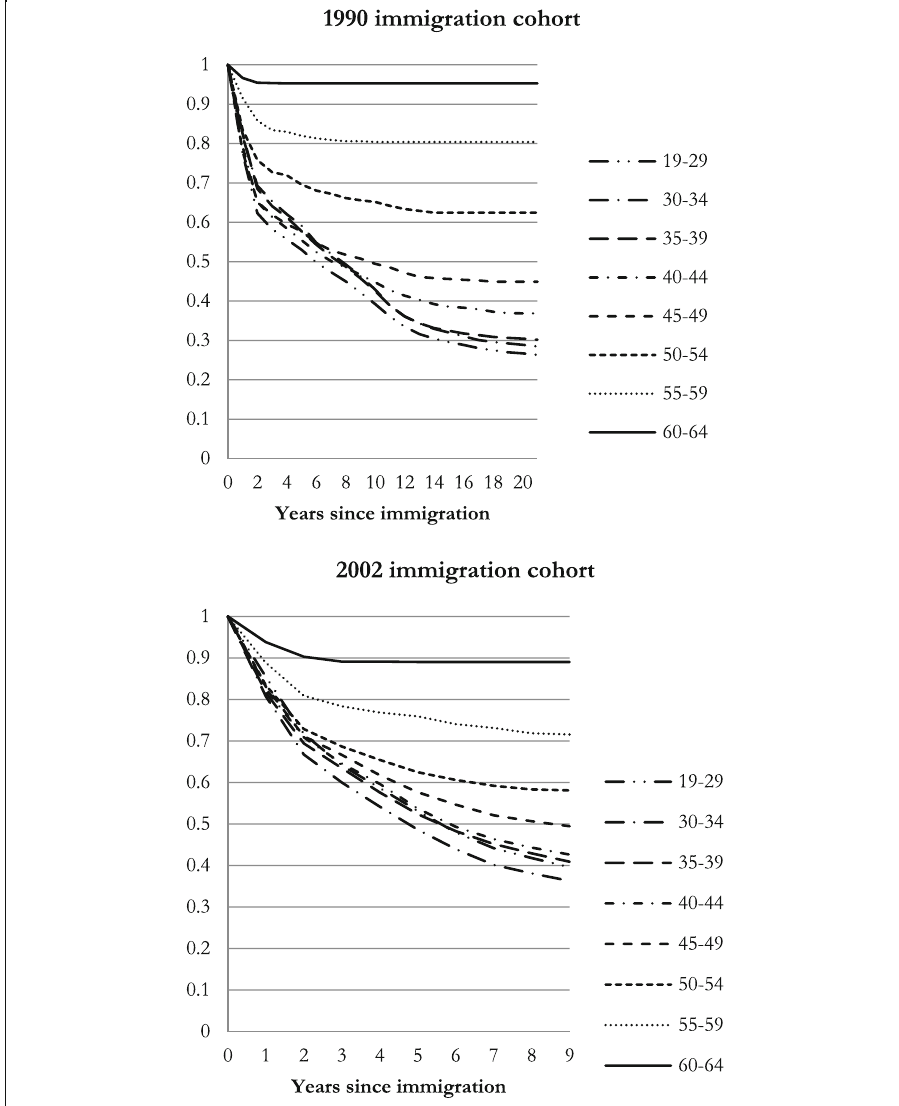
Fig. 6 a – b Life table survival estimates for time until annual income > 2 PBB by